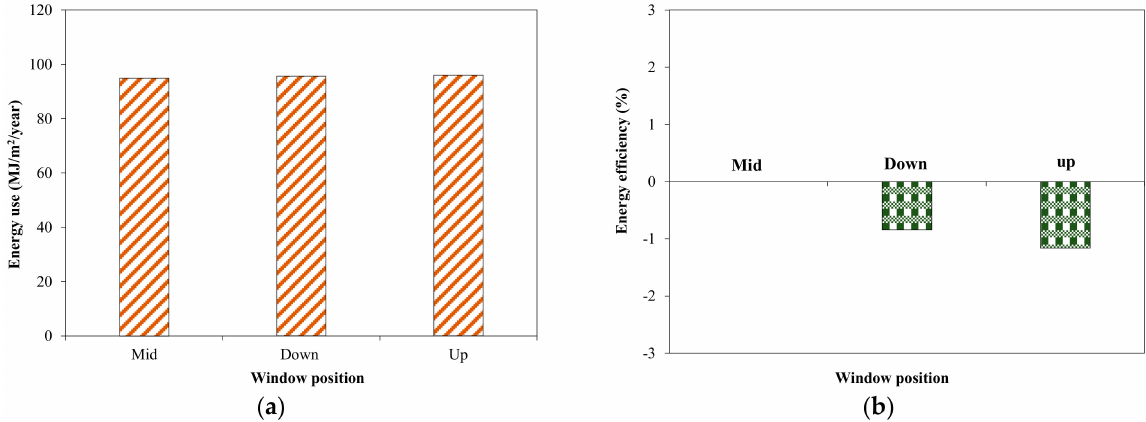
Figure 15. Effect of window position on energy use in tested house building. ( a ) Energy use; ( b )